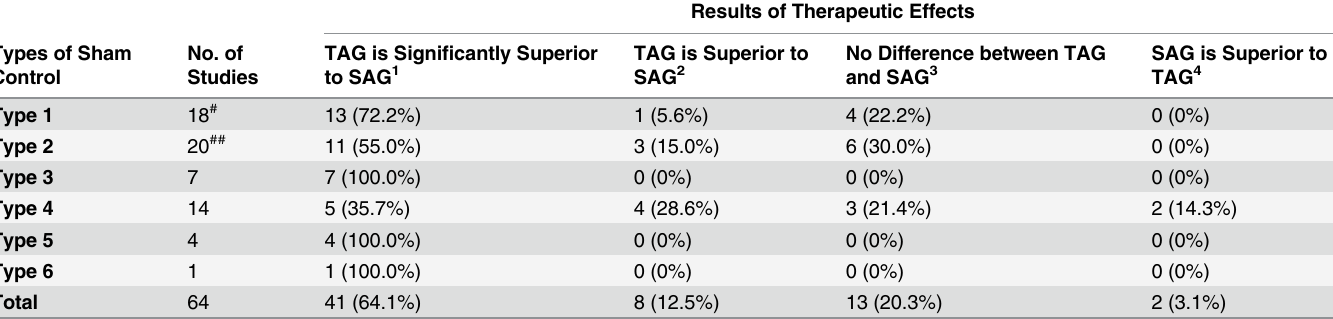
Table 4. Summary of the Therapeutic Outcomes based on Different Sham Acupressure